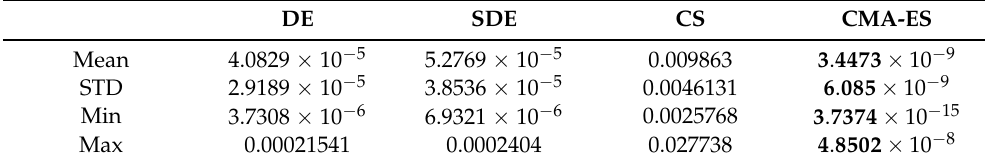
Table 9. Position error results for circular trajectory. The best results are highlighted in bold.